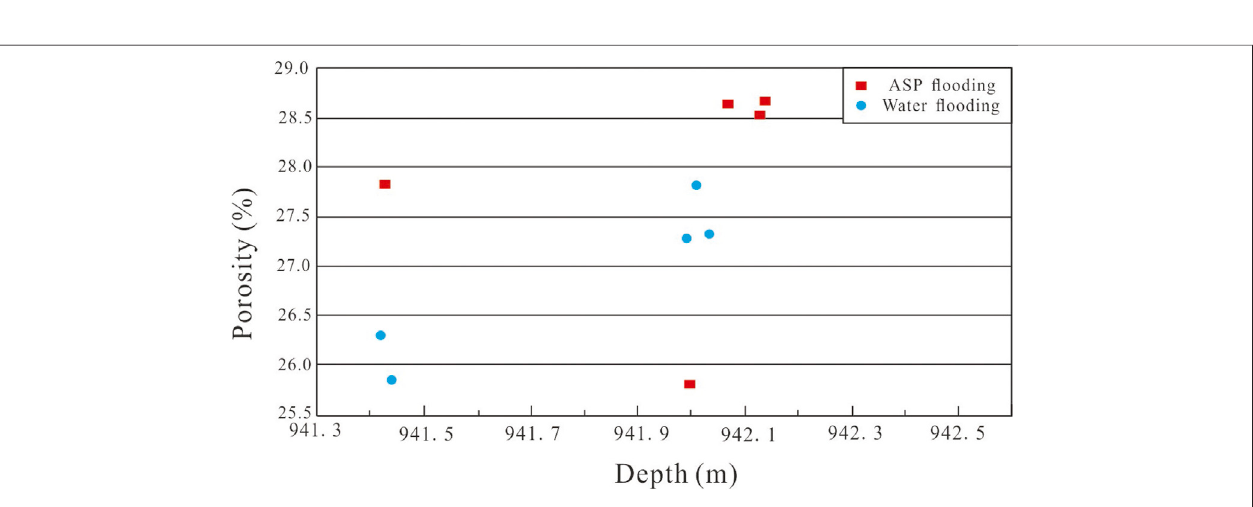
Frontiers in Earth Science |